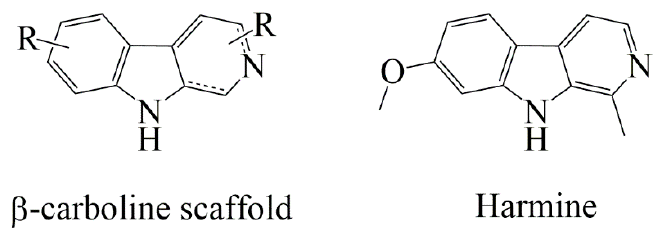
Figure 1. Structure of β -carboline scaffold and of the natural molecule harmine.